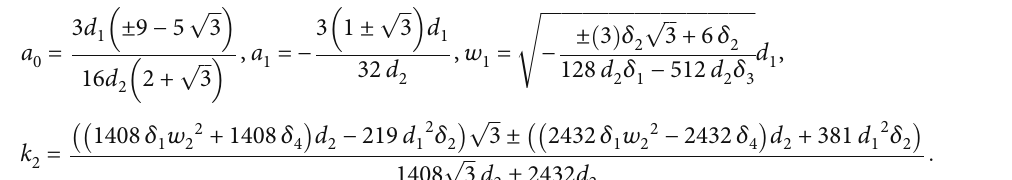
ð x , t Þj for NLFD of order α and for parameters δ 2